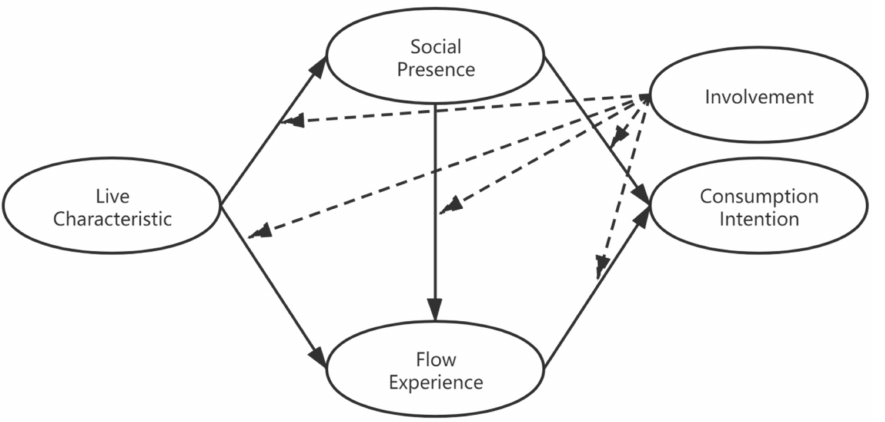
Figure 2. Theoretical